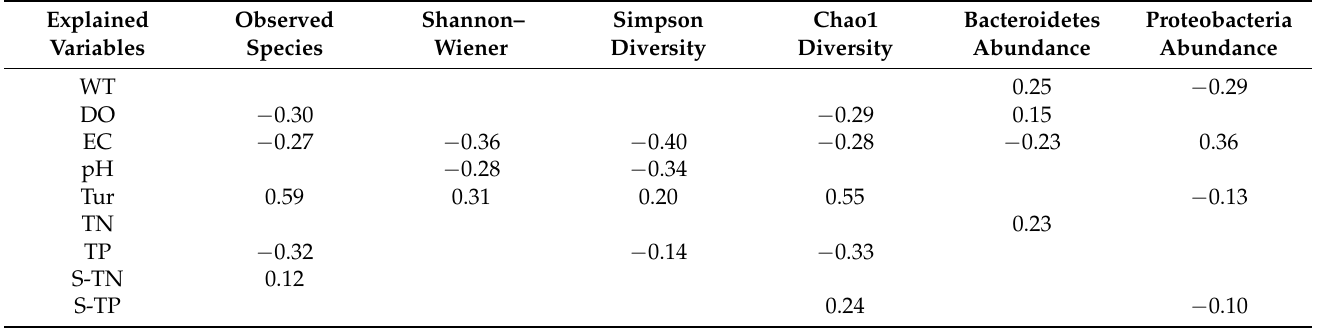
Table 1. The best-fitted structural equation models to determine the influence of environmental variables on sediment microbial community diversity index, Bacteroidetes and Proteobacteria abun- dance. Values are expressed as the standardized partial regression coefficients that were significant in the model.